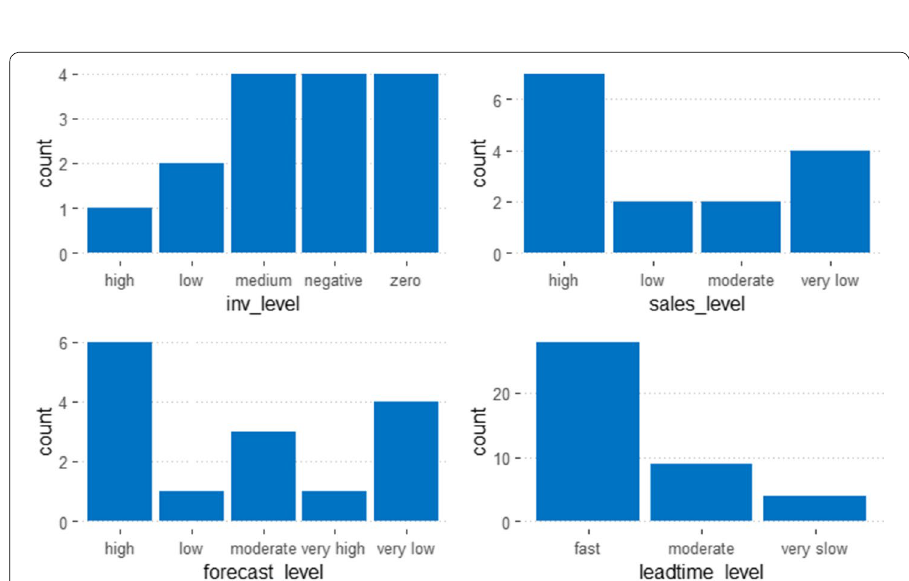
Fig. 16 Distribution of probable backorder cases for 20% backorder